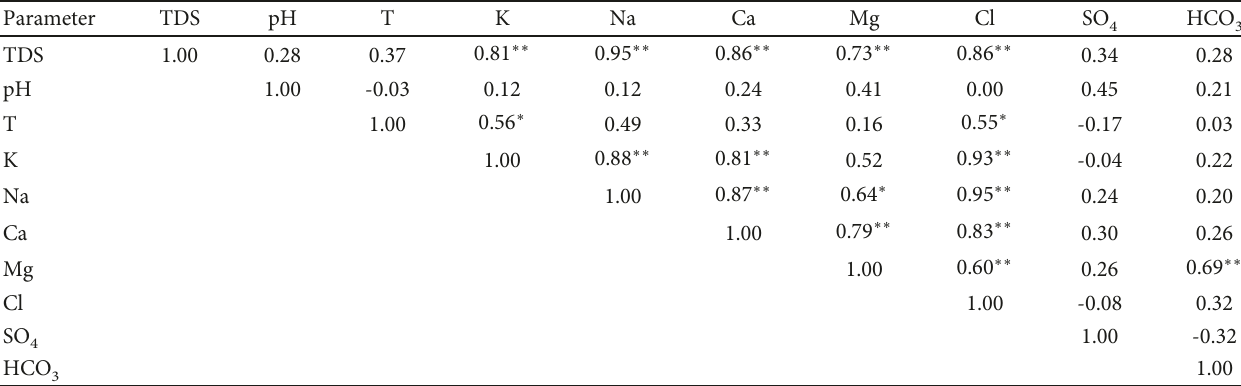
Table 3: Correlation matrix of physical and chemical parameters of the saline and salty springs (well) in western Sichuan Basin. Parameter